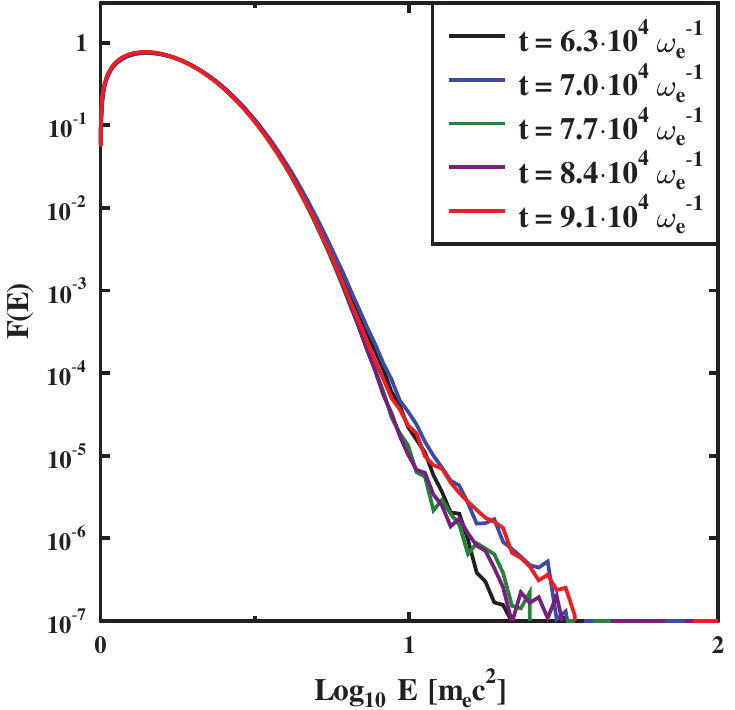
Figure 5. The electron distribution function in the shock downstream at different time